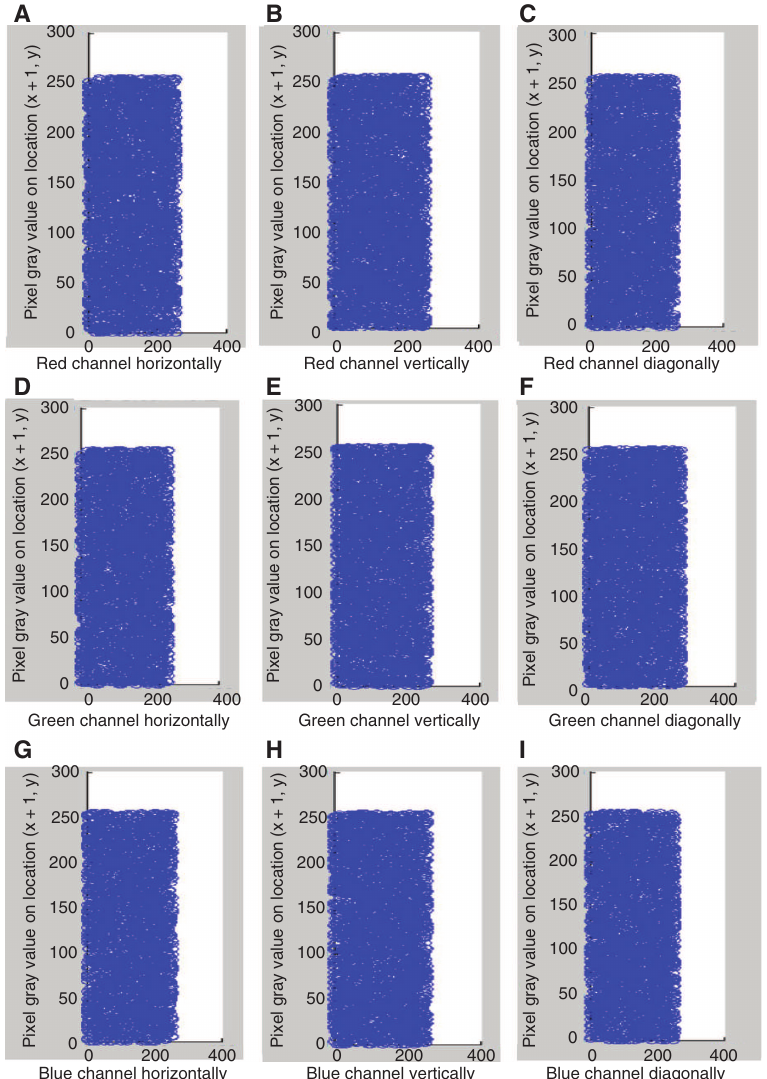
Figure 8: Correlation Distribution of Encrypted Red, Green, and Blue Channel of the Encrypted Image.